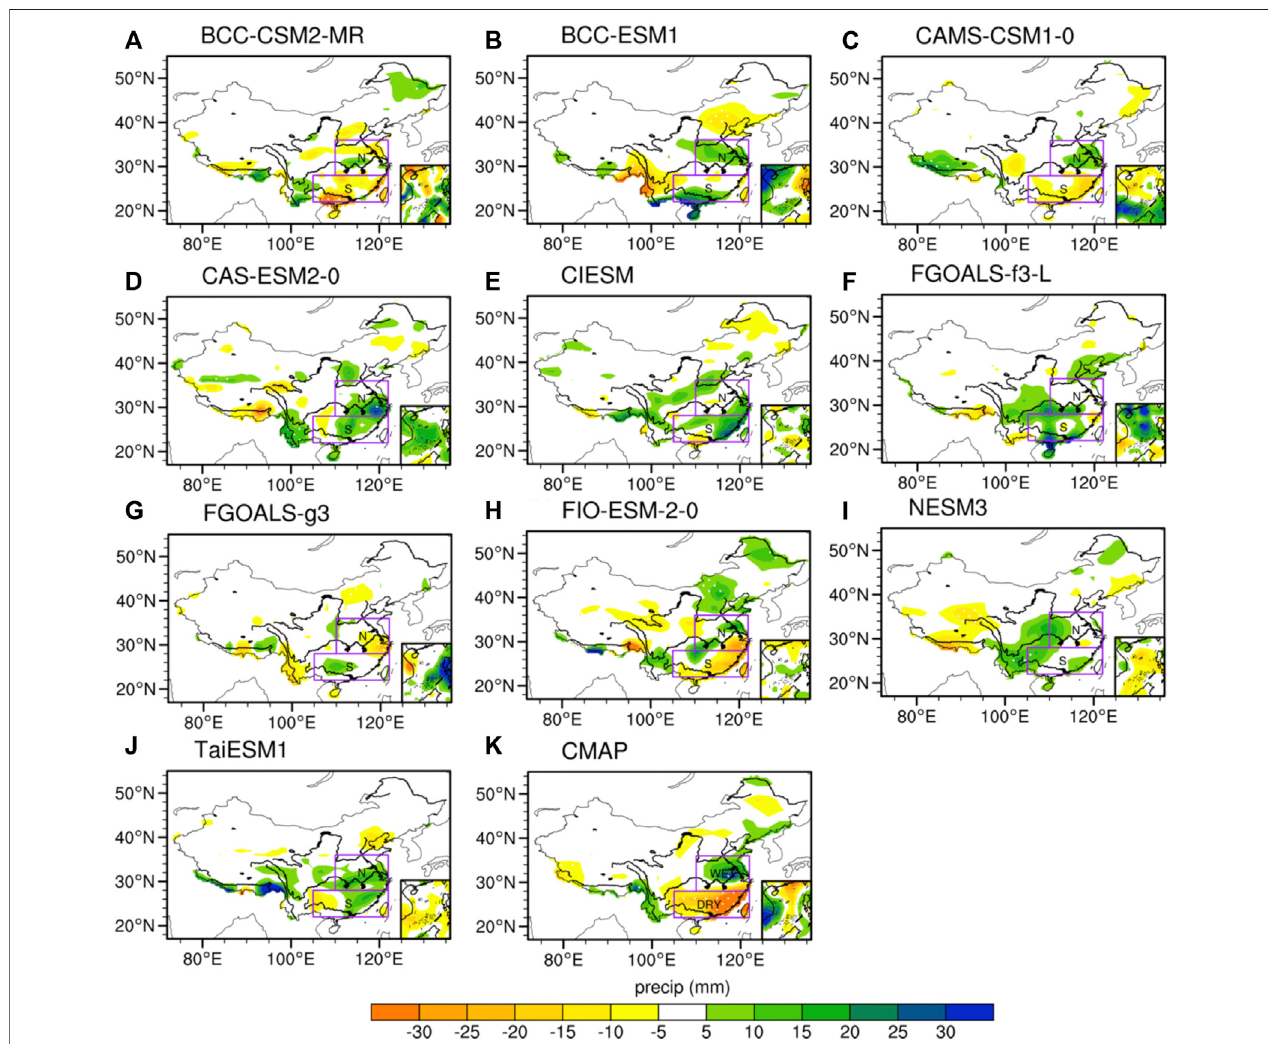
FIGURE10| UnderrepresentationofCMIP6modelsinproducingthelinkagebetweentheNovember – DecembermeanArcticseaiceinBarents – KaraSeasandthe JunerainfallinChinamainland. (A – J) RegressionofJunerainfallanomalies(units:mm)againstthestandardizedNovember – DecembermeanArcticseaiceconcentration inBarents – KaraSeasintheprecedingearlywinterfor10modelsfromChina. (K) Replicatedfrom Figure6A showingtheregressionforCMAPasaveri fi cationreference.